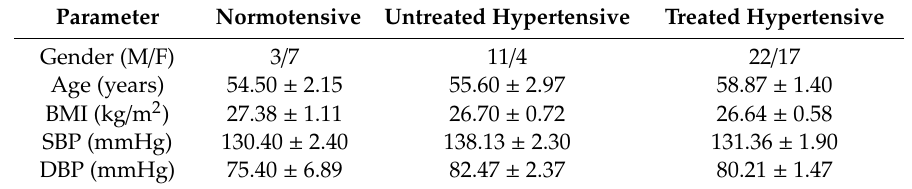
Table 1. Characteristics of the participants involved in short chain fatty acid (SCFA) analysis.